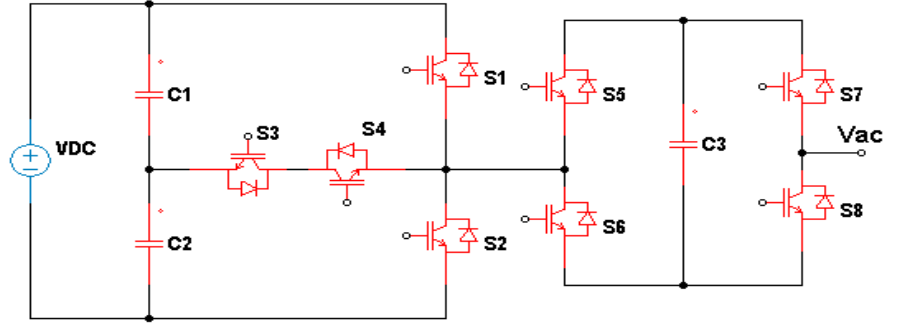
Figure 5. Another Seven-level inverter topology.